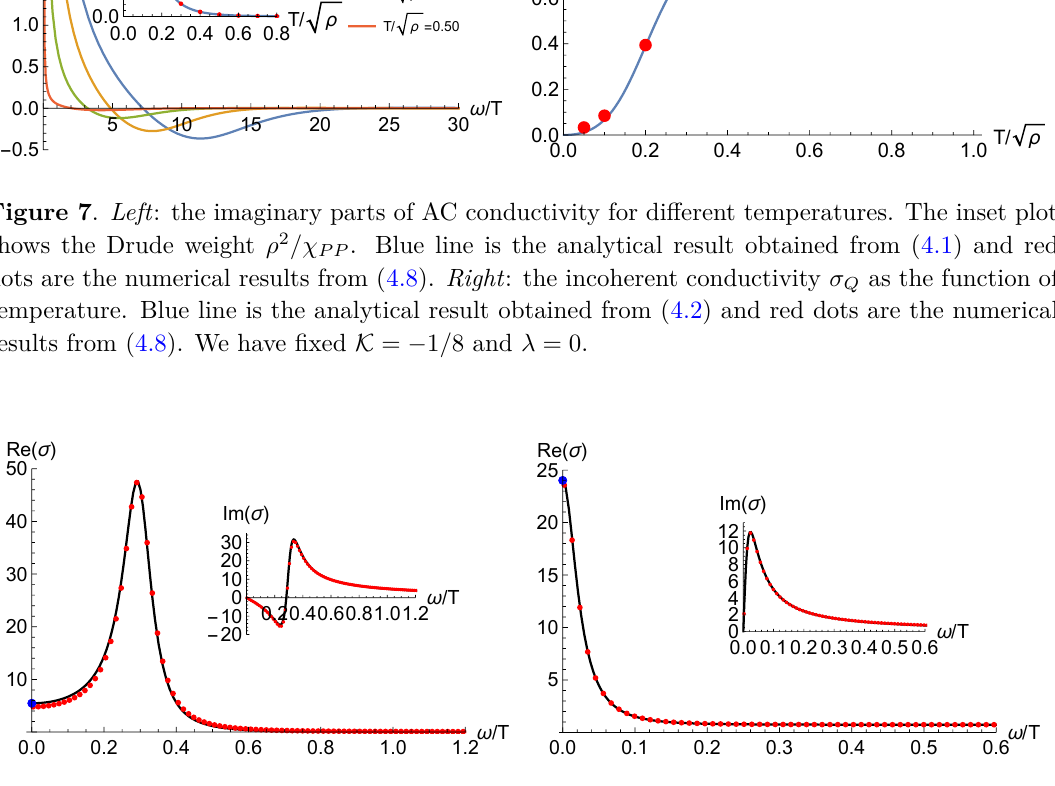
Figure 8 . Comparisons between numerical AC conductivities (black solid lines) and hydrodynamic predictions (red dots) for different temperatures. The blue dots are the DC conductivity results √ from (4.9). Left : T/ ρ = 0 . 1 and ω 2 ≈ 0 . 0017 . Here, one should distinguish ω 0 -the mass of pinned 0 phonons and ω , the peak of the conductivity in IR region. Right : T/ peak λ = 1 × 10 − 7 and K = − 1 / 8